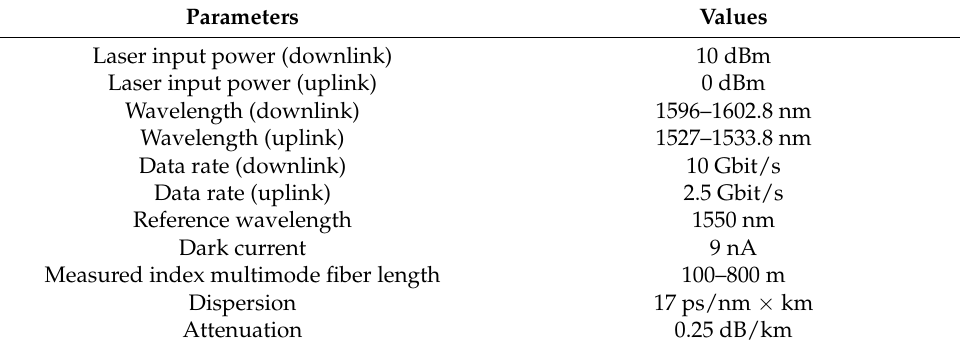
Table 2. Parameters used